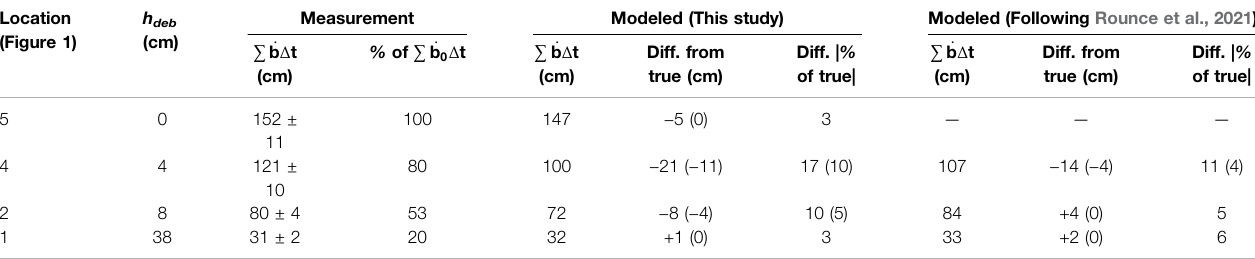
TABLE 1| Cumulative melt ( (cid:12) _ b Δ t )from August1st2:00 AKDTtoAugust 28th13:00AKDT 2016. Difference, inparentheses,isthedifference relative tothenearest ( ± )error bound, where “ (0) ” means the sum fell within the error bounds. h deb Location (Figure 1) (cm)